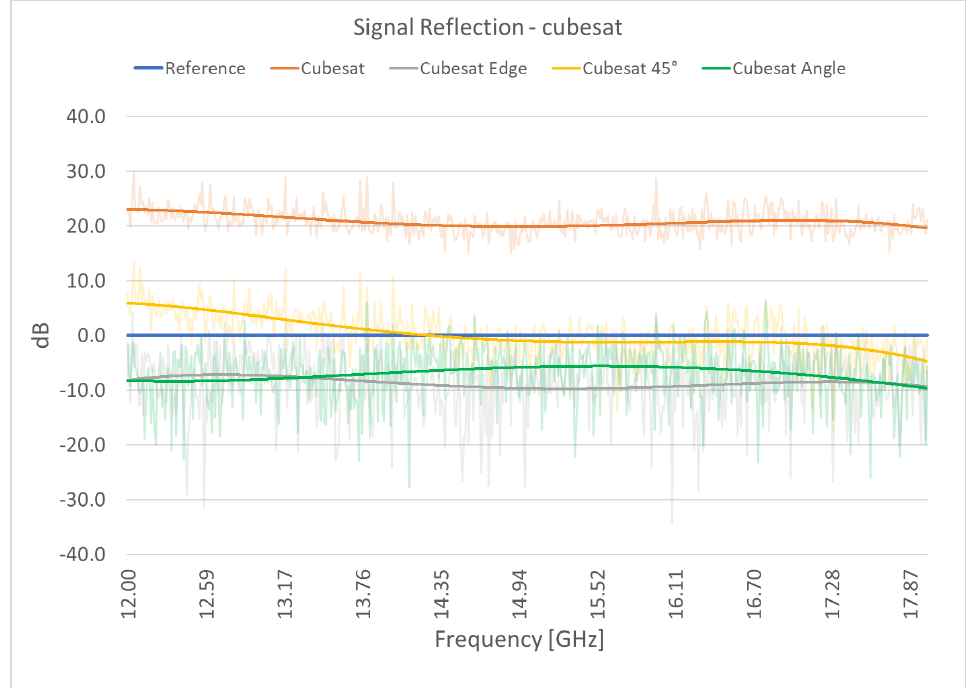
Figure 3. Cubesat signal reflection: TE polarization reflection vs. frequency.